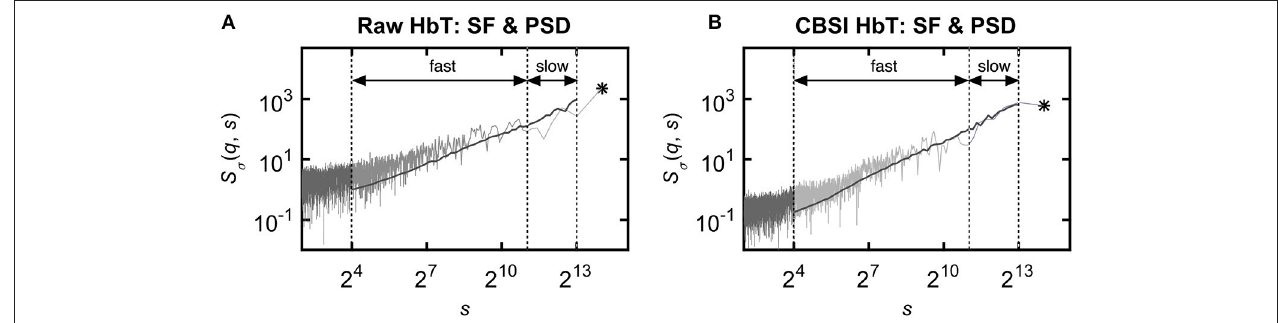
FIGURE 7 | Relationship between power spectrum and scaling function profiles obtained by the FMF-SSC method. Although multifractal analyses were performed in the time domain, its design and results can be interpreted in the frequency domain as well owing to the explicit relationship between representation of dynamics in the temporal and the spectral domains both for the raw (A) and CBSI-pretreated (B) signal. The ordinate shows both frequency and temporal scale. It is the variance profile at q = 2 that corresponds well with the mean spectral estimates. The range of spectral estimates fall in between S ( q , s ) profiles for q = 15 and q = − 15. The fractal scaling range emerges from the (non-fractal) noise (of biological origin) dominating the low temporal scales. It contains a breakpoint, which separates S (2, s ) into a slow (associated with high temporal scales) and a fast (associated with intermediate temporal scales) scale-free component. This appears as a low- and a very-low frequency spectral band in the frequency domain. For further details, see text. Component-based focus is indicated by asterisk (*) as ln( ˆ S σ ( N )) for the raw (A) and ln( ˆS σ ( N )) for the CBSI-pretreated HbT signal (B)